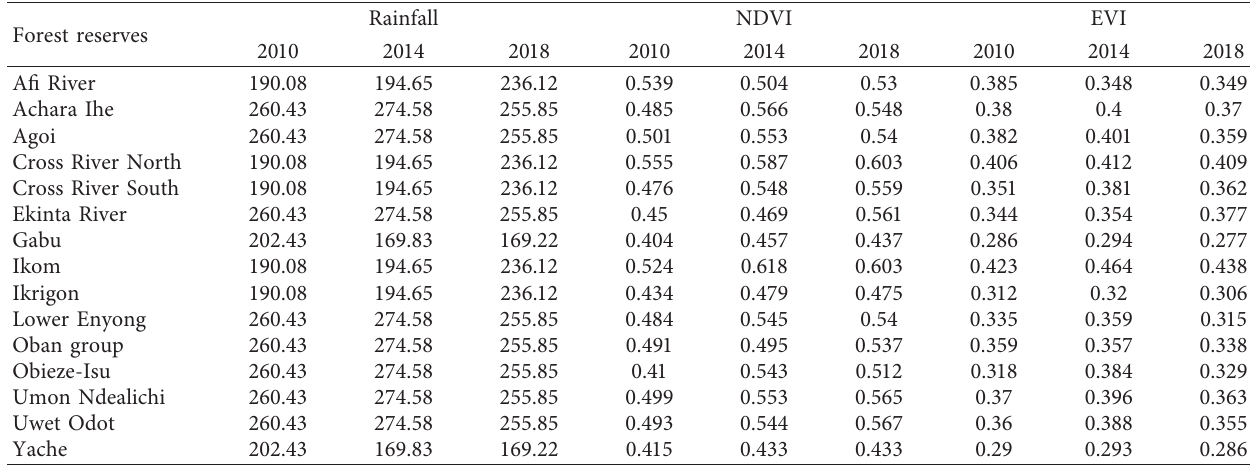
Table 2: Yearly rainfall data and vegetation indices.